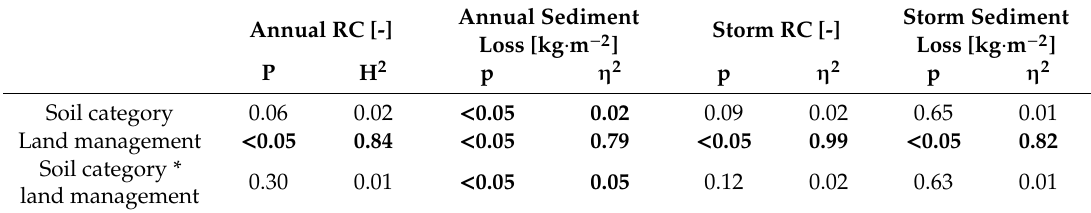
Table 16. Significance ( p ) and e ff ect size ( η 2 ), testing depth- and soil-related influence on RC and sediment loss (Two-way ANOVA for soil categories FOR, CUT, SUC and REF). Significant values appear bold.